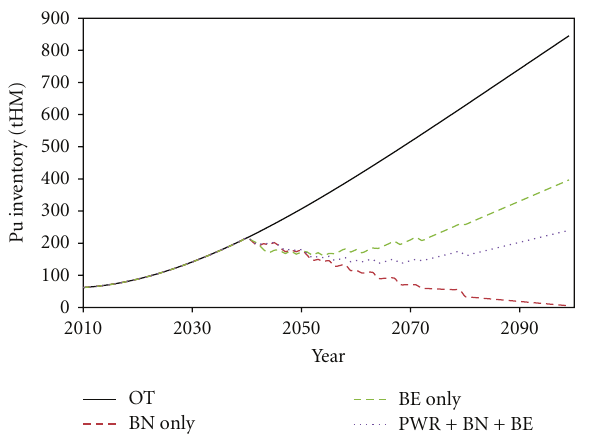
Figure 10: Pu inventory. Figure 11: MA